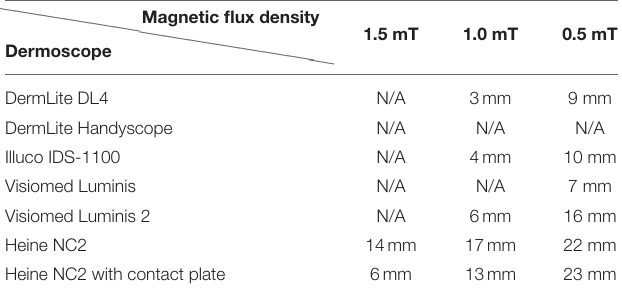
TABLE 2 | The distance from the dermoscope faceplate in a vertical plane at which the magnetic flux density of 0.5, 1.0, and 1.5 was